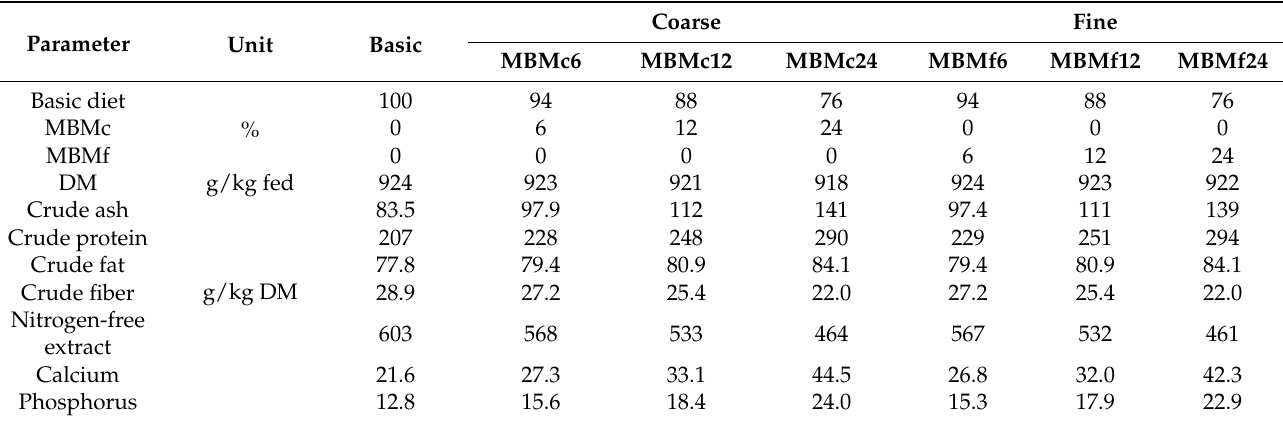
Table 1. Chemical composition of the basic diets supplemented with different levels and particle sizes of